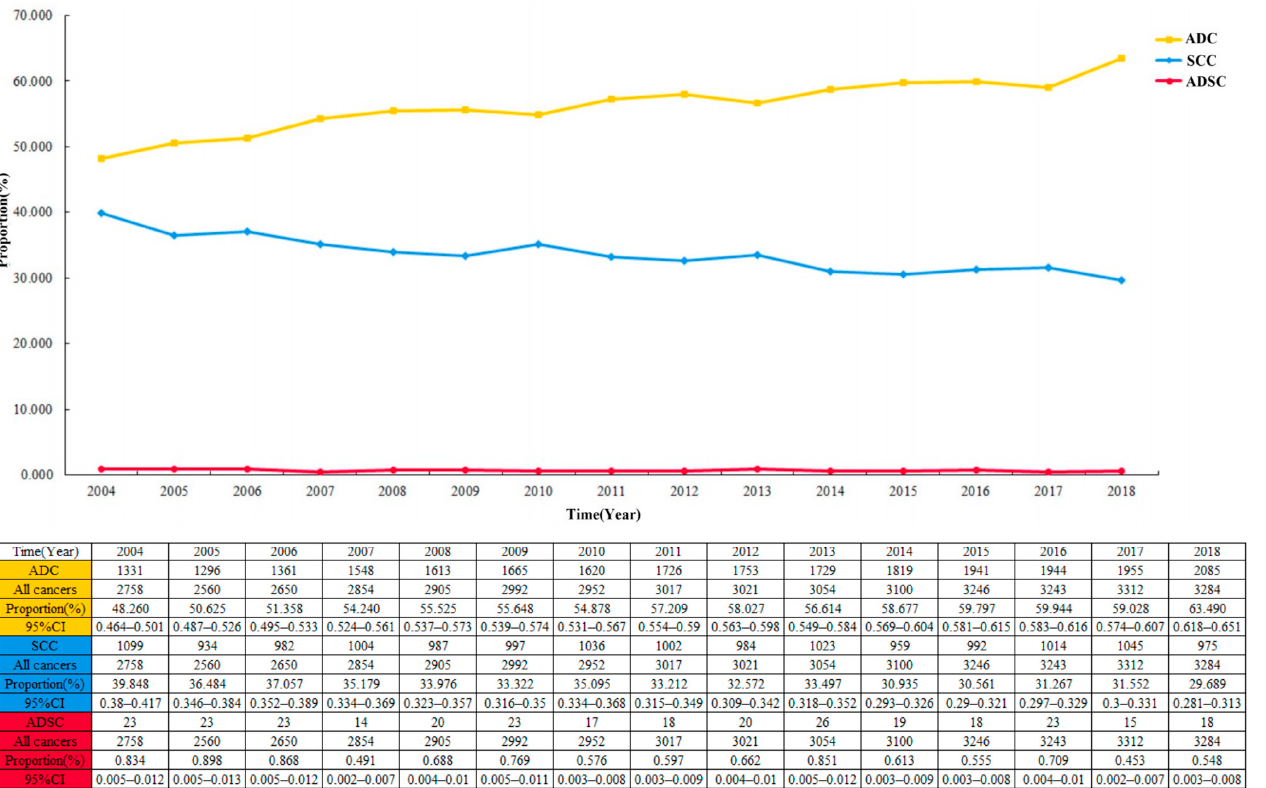
Figure 3. The crude incidence rate of three different pathological types of esophageal cancer over time in 44,948 patients. Table 3. The results of multivariable logistic regression analyses.